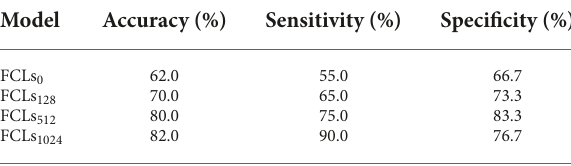
TABLE 6 The influence of different fully connected layers on the classification of the VGG model.